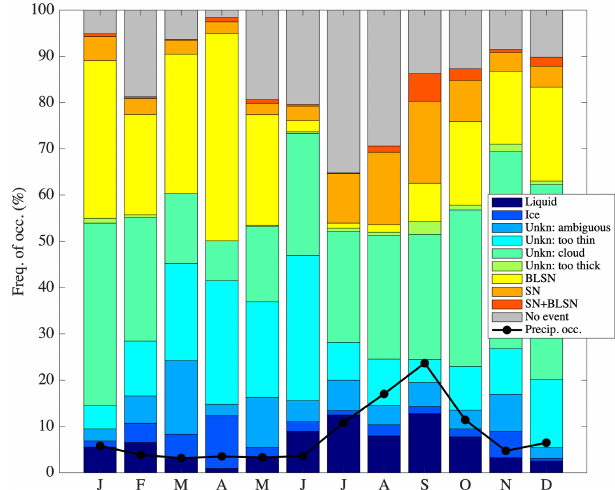
Figure 5. Composite monthly frequencies of occurrence of each classification. BLSN and SN refer to blowing snow and snow, respectively. Precipitation occurrence is the sum of SN and